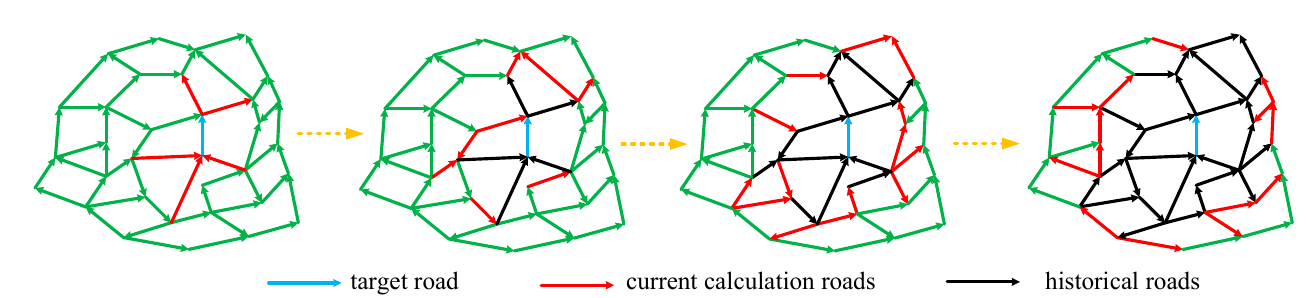
Figure 5. Calculation process of the STC between different roads and the TR.